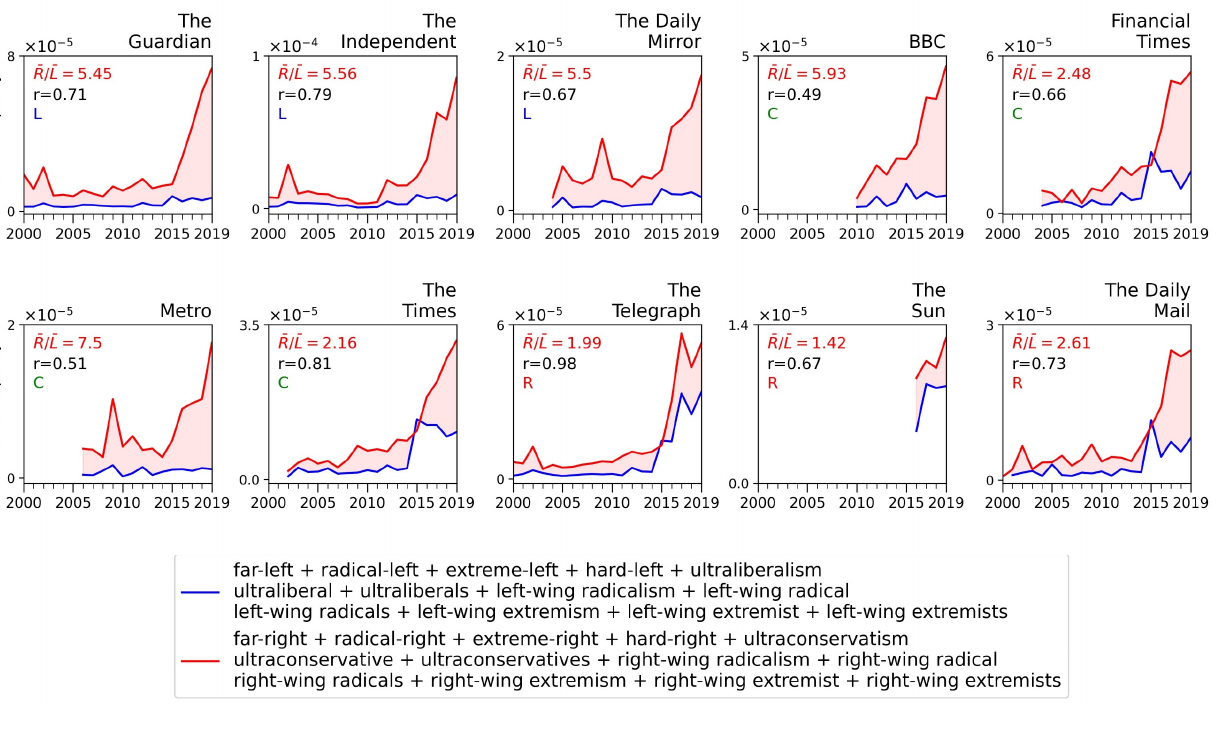
Figure 5. Yearly prevalence of an aggregate set of terms denoting far-right (red line) and far-left (blue line) political extremism in popular U.K. news media outlets. The colored area between time series for each outlet is used to highlight the dominant prevalence. Red areas indicate higher prevalence of far-right denoting terms. Conversely, blue areas would indicate higher prevalence of far-left denoting terms. The average prevalence ratio between both time series ( R / L or L / R ) is also color-coded according to which ratio is dominant. The Pearson correlation coefficient, r, between the time series is shown on the top left of each subplot. The political bias from each outlet, according to a majority voting from media bias rating sources including AllSides Media Bias Chart 2019 v1.1 (AllSides 2019), YouGov (YouGov 2021) and Ad Fontes Media (Andrew McGee 2021), is indicated with L (left-leaning), C (center-leaning) and R (right-leaning).